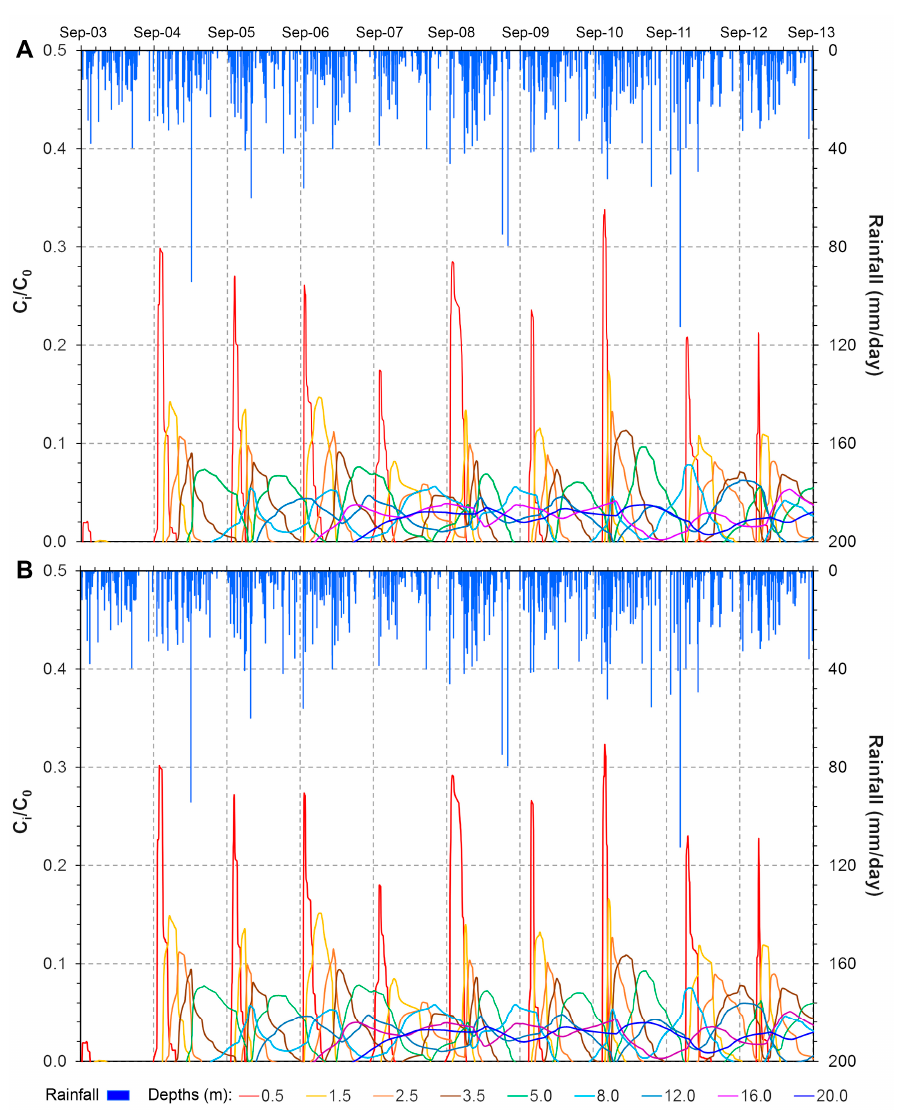
Figure 5. Example of a modeled breakthrough curve of nitrate pollutant, expressed as the ratio C i / C 0 , obtained for the homogeneous loamy sand soil hydro-stratigraphic model and by setting one-day spill inputs of nitrate fertilizer pollutant with different concentrations: ( A ) 1.0 mg/L; ( B ) 3.0 mg/L.